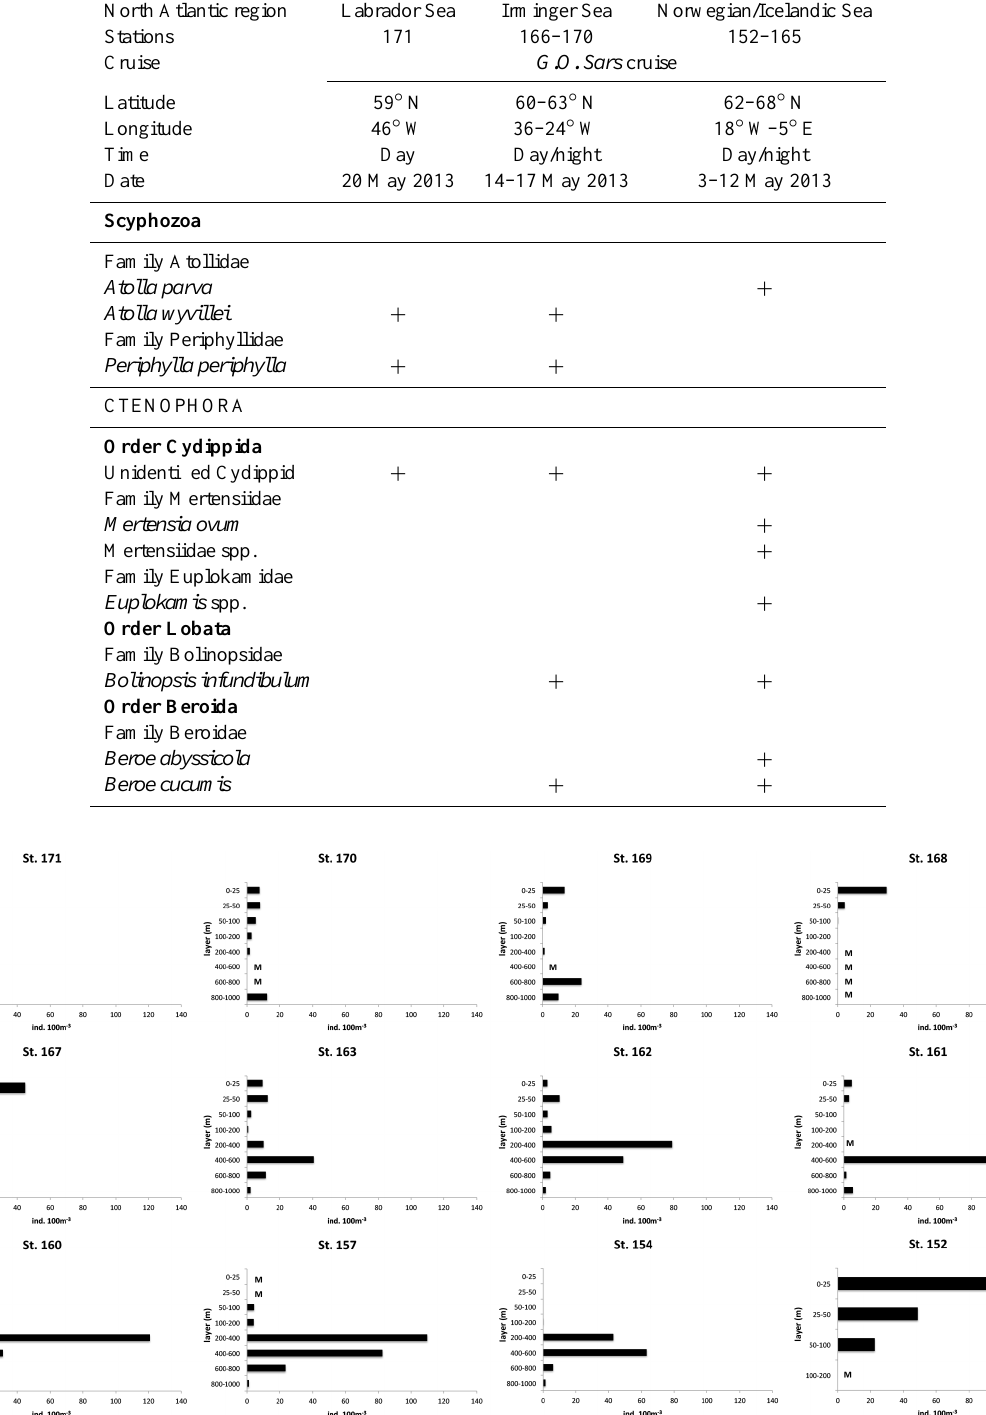
Earth Syst. Sci. Data, 7, 173–191,